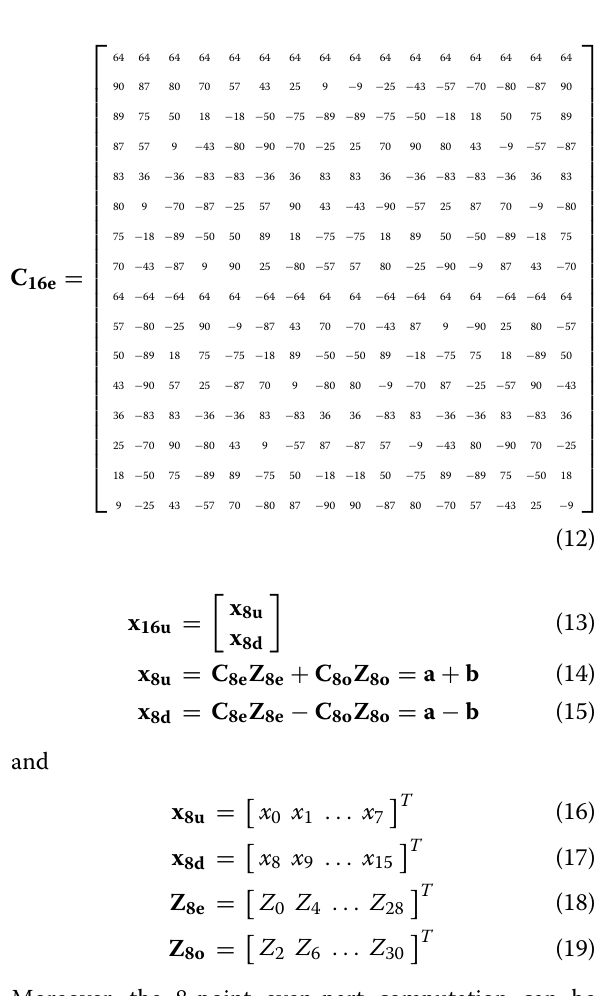
Fig. 1 Decomposition of the 32-point inverse discrete cosine transform (IDCT) computation